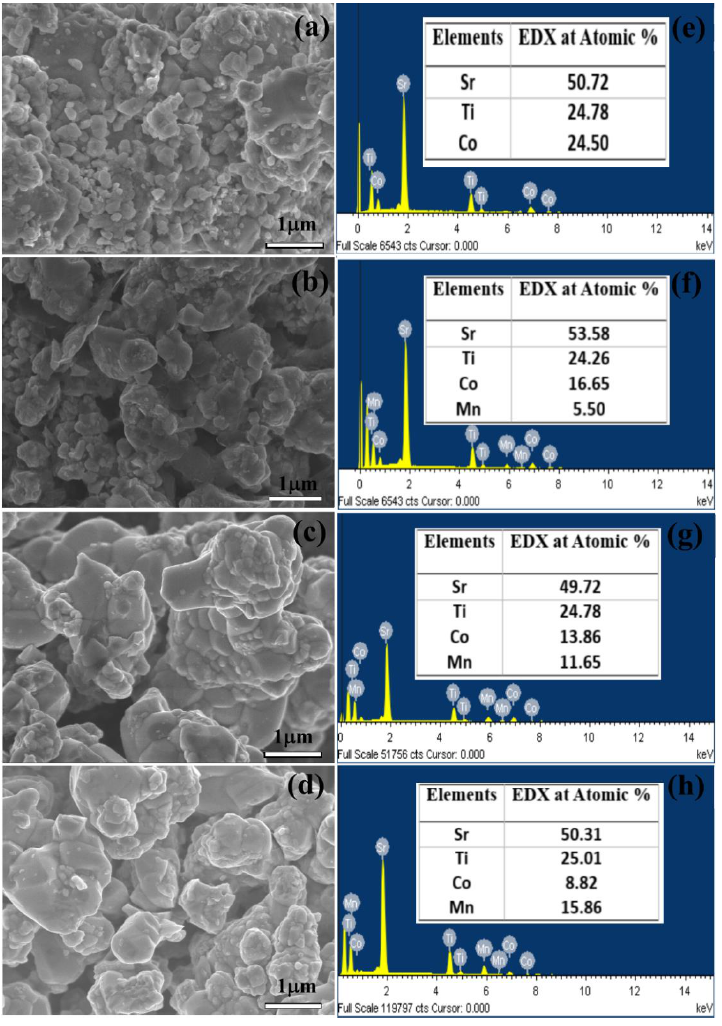
Figure 3. FESEM images of ( a ) STC, ( b ) STCM3, ( c ) STCM5, and ( d ) STCM7 materials at 20 k magnification; ( e – h ) are their corresponding EDX spectra, respectively.